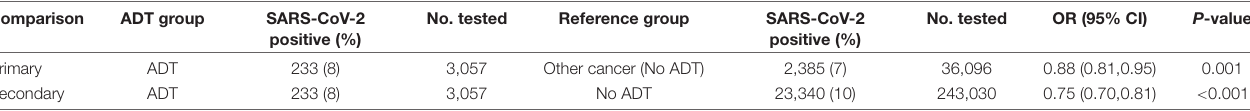
TABLE 2 | Association between ADT use and SARS-CoV-2 positivity.